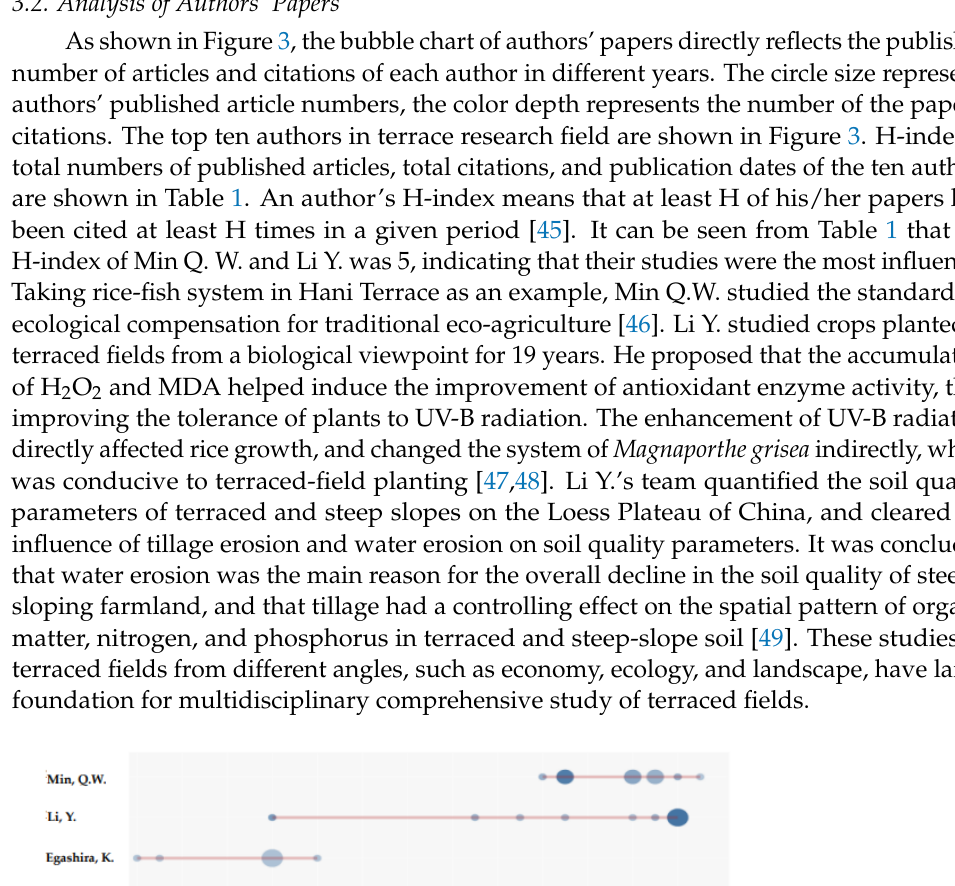
Figure 2. Agricultural-terrace research articles and citations during 1991 – 2020.